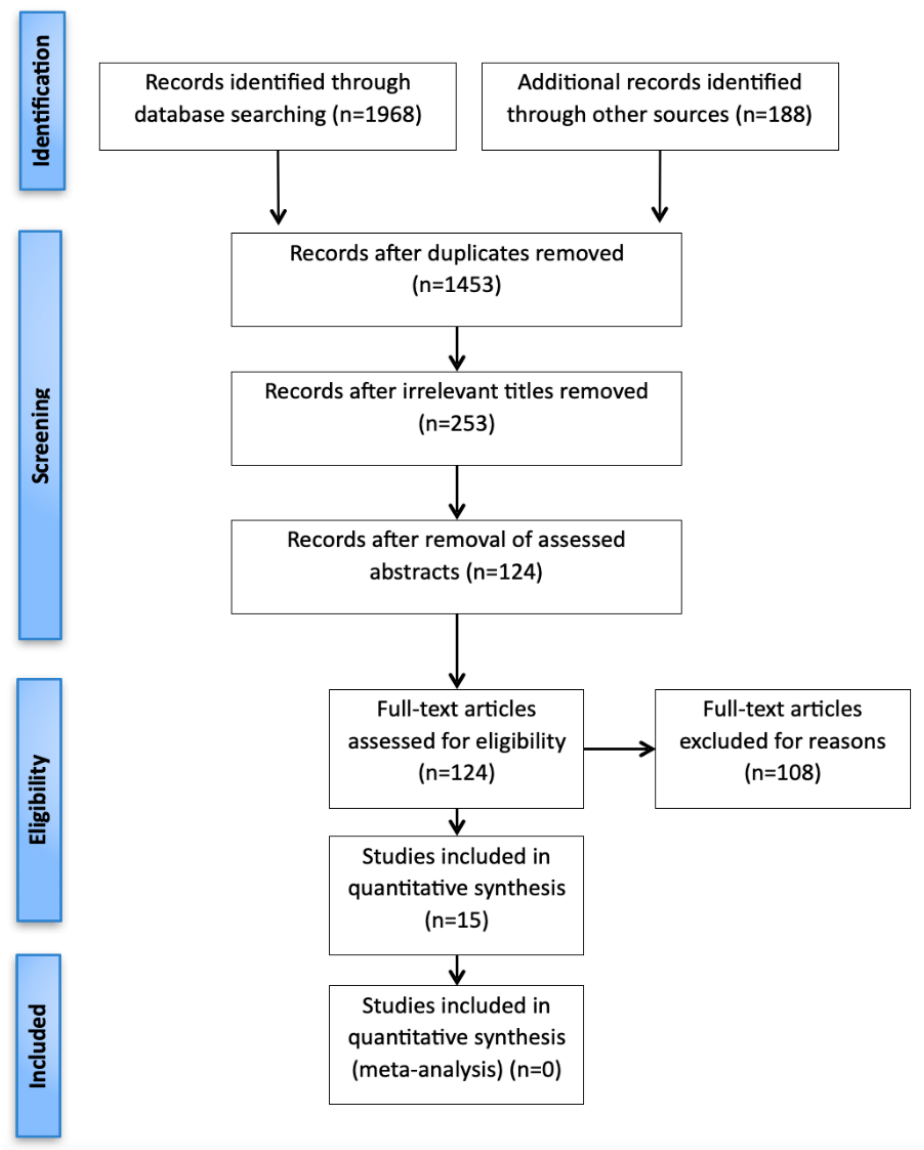
Figure 1. PRISMA study flow diagram.